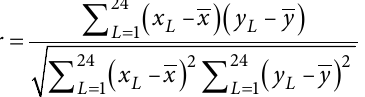
Table 3. Determining the Pearson correlation